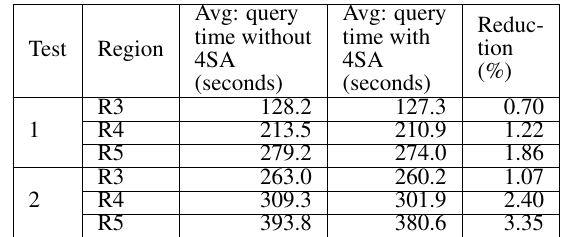
Table 4. Index searching times for large query regions with large numbers of concurrent